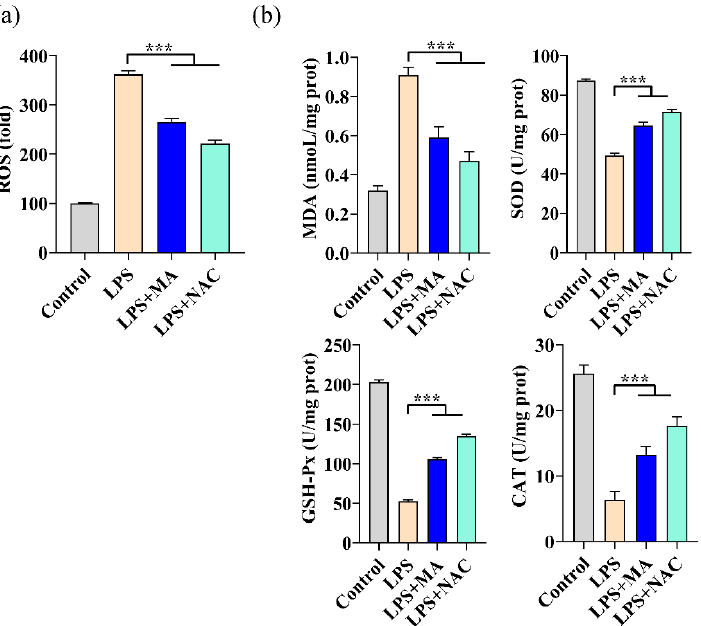
Figure 3. MA mitigates LPS-induced oxidative stress in RAW264.7 cells. Treatment with 100 mg/L MA for 12 h or 10 μ M NAC (Positive control) for 30 min, followed by 1 mg/L LPS for 24 h. ( a ) The level of intracellular ROS was measured by DCF fluorescence using an enzyme marker. ( b ) MDA concentration was analyzed with 2-thiobarbituric and the activities of antioxidant enzymes includ- ing SOD, GSH-Px, and CAT were determined using ELISA kits. Data are shown as mean ± SEM obtained from three independent experiments. *** p < 0.001.